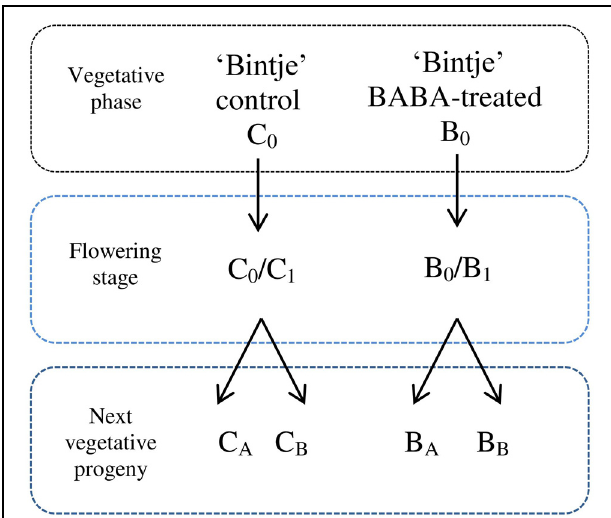
FIGURE 1 | Experimental design for the generation of progeny lines. C 0 – control plant in vegetative phase, B 0 – plants subjected to immunization with different BABA doses in vegetative phase, C 0 /C 1 – control plants in flowering stage, B 0 /B 1 – specimen in flowering stage previously supplied with BABA in B 0 phase, C A – a batch of healthy plants originating from non-induced C 0 parents, obtained from lateral buds propagated through in vitro seedlings from BABA-treated parental line, C B –regenerated from tubers, B A – plant line generated by in vitro micropropagation of BABA-primed parents (in B 0 phase), B B –regenerated from B 0